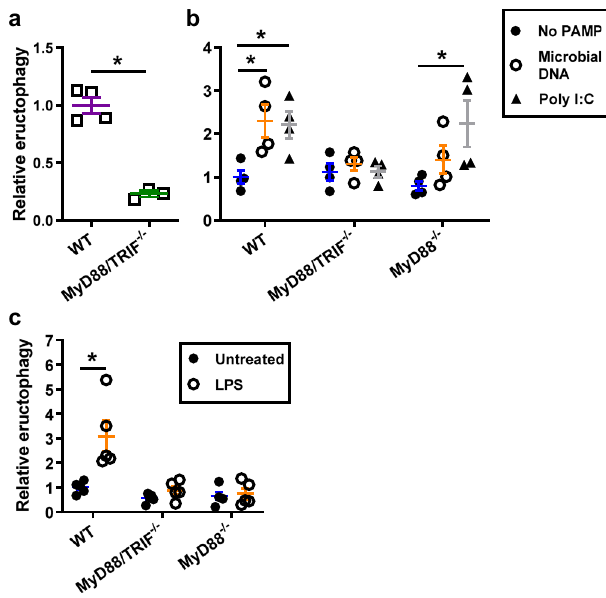
Fig. 8 Eructophagy in macrophages is induced by TLR activation. a Rates of eructophagy as detected by extracellular resoru fi n maltotriose hydrolysis by phagolysosomal α -amylase (sourced from Bacillus licheniformis ) coupled to reporter particles in BMMØs de fi cient in MyD88 and TRIF, relative to BMMØs derived from WT mice. b , c Relative rates of eructophagy as detected by phagolysosomal pH using PAMP-free CFSE-BSA-coupled particles b with or without particle-adsorbed TLR ligands (microbial DNA or Poly I:C); or c the addition of 10ng/mL extracellular LPS 30min post- phagocytosis by BMMØs derived from WT, MyD88/TRIF − / − or MyD88 − / − mice. a , b n = 4 biologically independent experiments. c n = 5 biologically independent experiments. Error bars presented as means±SEM. by a * P = 0.0003 Student ’ s two-tailed unpaired t -test, or b , c * P ≤ 0.05 two- way ANOVA with Bonferroni comparison of means. Source data are provided as a Source Data fi